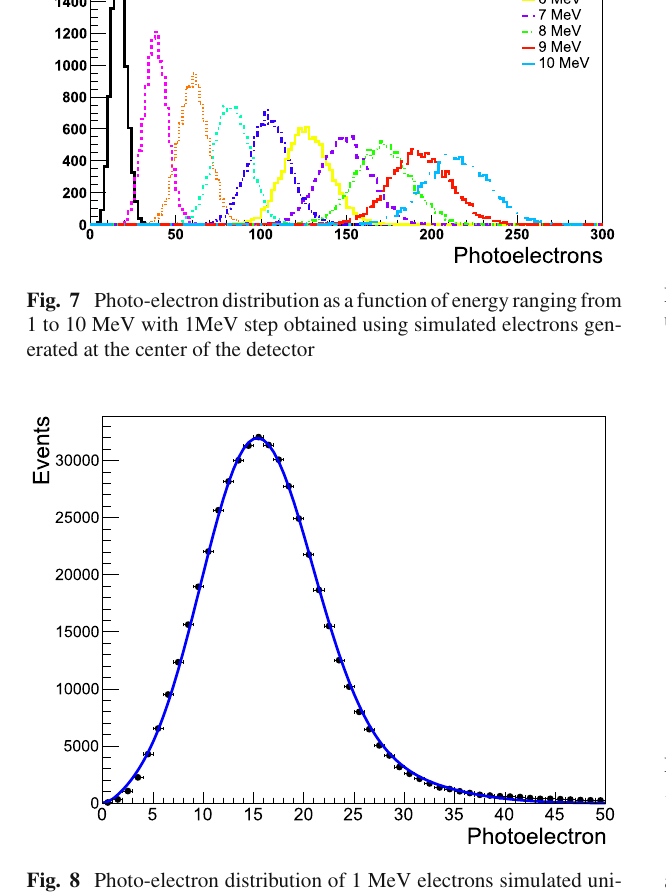
Fig. 8 Photo-electron distribution of 1 MeV electrons simulated uni- formly in the inner fiducial volume of the detector and fitted with a convolution of Gaussian and Landau function using RooFit